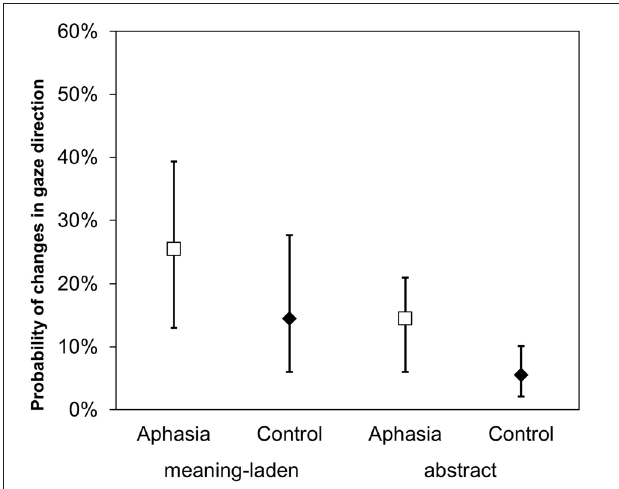
FIGURE 3 | Changes in gaze direction. An illustration of the main effects of gesture category and group on the dependent variables probability of change in gaze direction. Error bars represent the 95% confidence intervals around the estimated values.